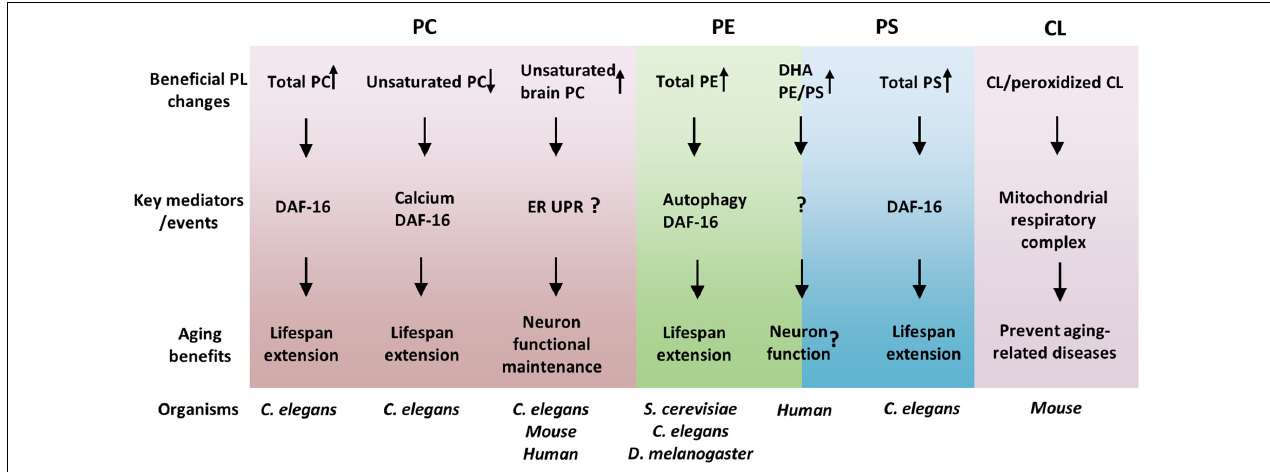
FIGURE 1 | Phospholipids (PLs) regulate aging via overlapped but distinct molecular mechanisms. PL species with beneficial effects on healthspan and lifespan were suggested and their key mediators were listed. Among the mediators, DAF-16 seems to be common and important for many PLs effects. Moreover, the functions of organelles, such as the ER and mitochondria, are crucial links between PLs and aging, consistent with PLs as membrane lipids.